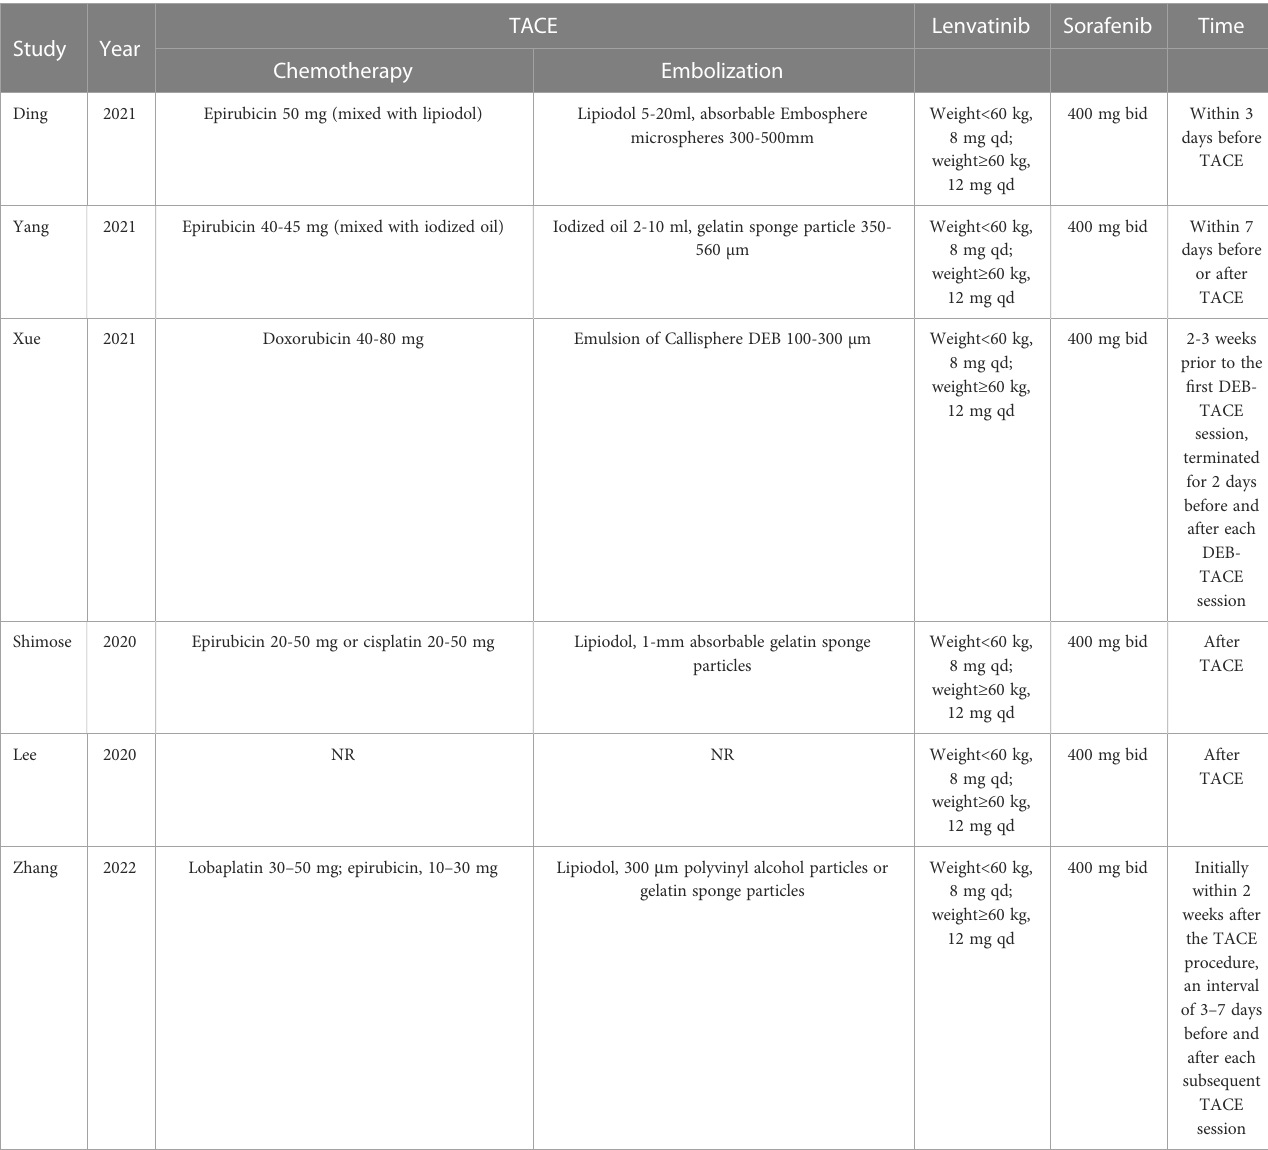
TABLE 2 Procedures of lenvatinib plus TACE and sorafenib plus TACE combination therapy.